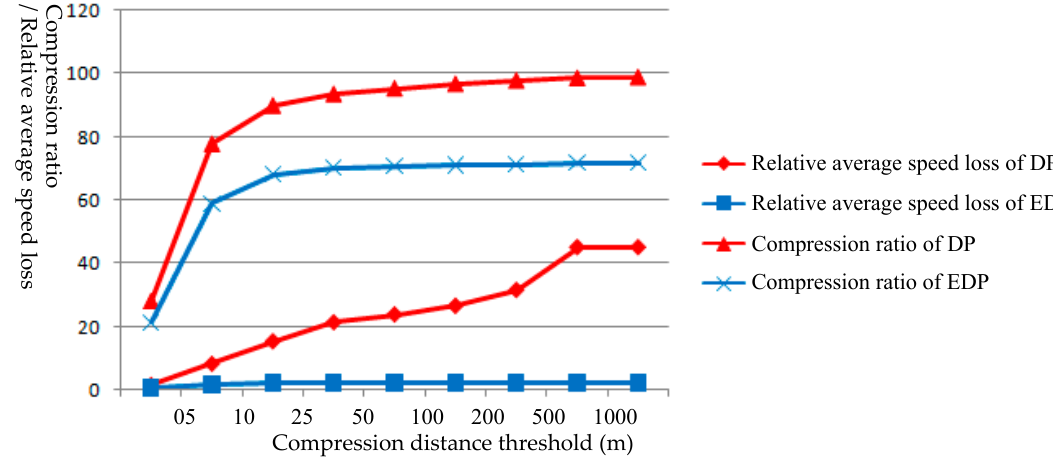
Figure 14. Relative average speed loss and compression ratio of DP and EDP algorithms in the post-simplification data of Trajectory 2 with different distance thresholds.